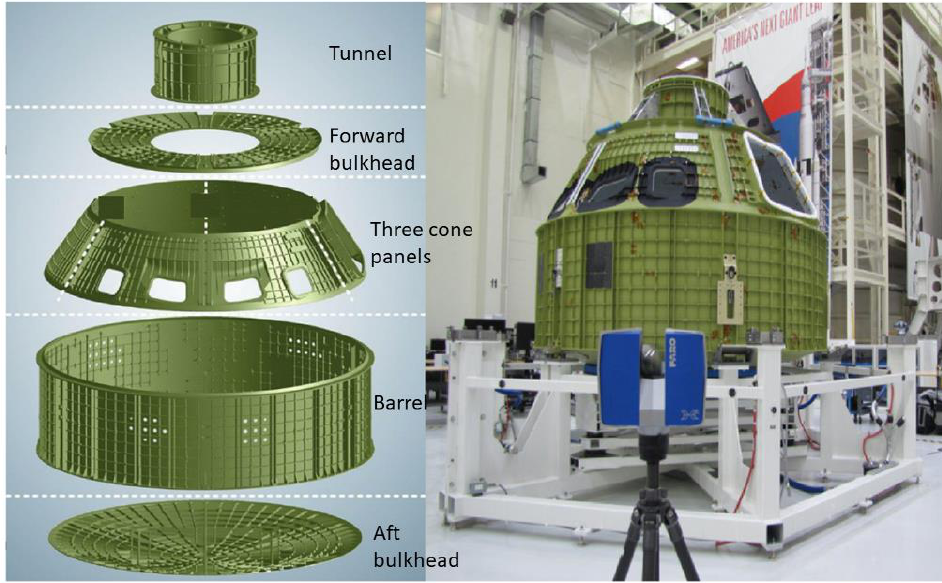
Figure 25. Orion crew’s primary structure and its seven parts which to be welded (NASA) (reprinted from educator guide [129,130] permission not required).